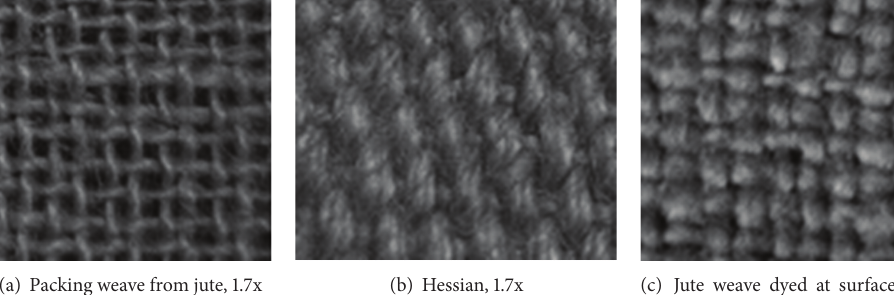
Figure 7: Images of weaves from jute.